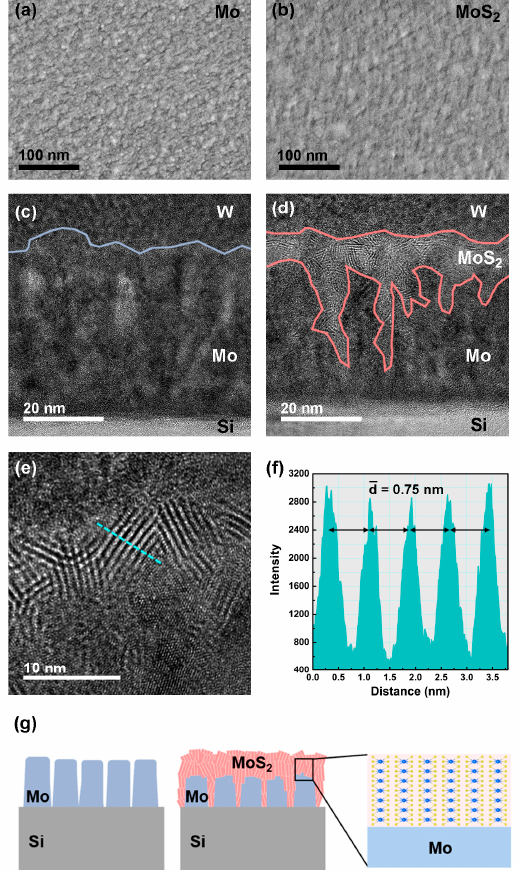
Figure 3. Typical SEM images of the ( a ) Mo film surface deposited via RF sputtering and ( b ) MoS 2 film surface after the PECVD synthesis process. Cross-sectional TEM images of ( c ) Mo deposited on the Si substrate and ( d ) MoS 2 grown on the Si substrate. ( e ) Cross-sectional high-resolution transmission electron microscopy (HRTEM) image of MoS 2 with a layered structure. ( f ) Intensity profiles corresponding to the blue dotted line in ( e ). ( g ) Schematics of Mo deposited on the Si substrate and sulfurized MoS 2